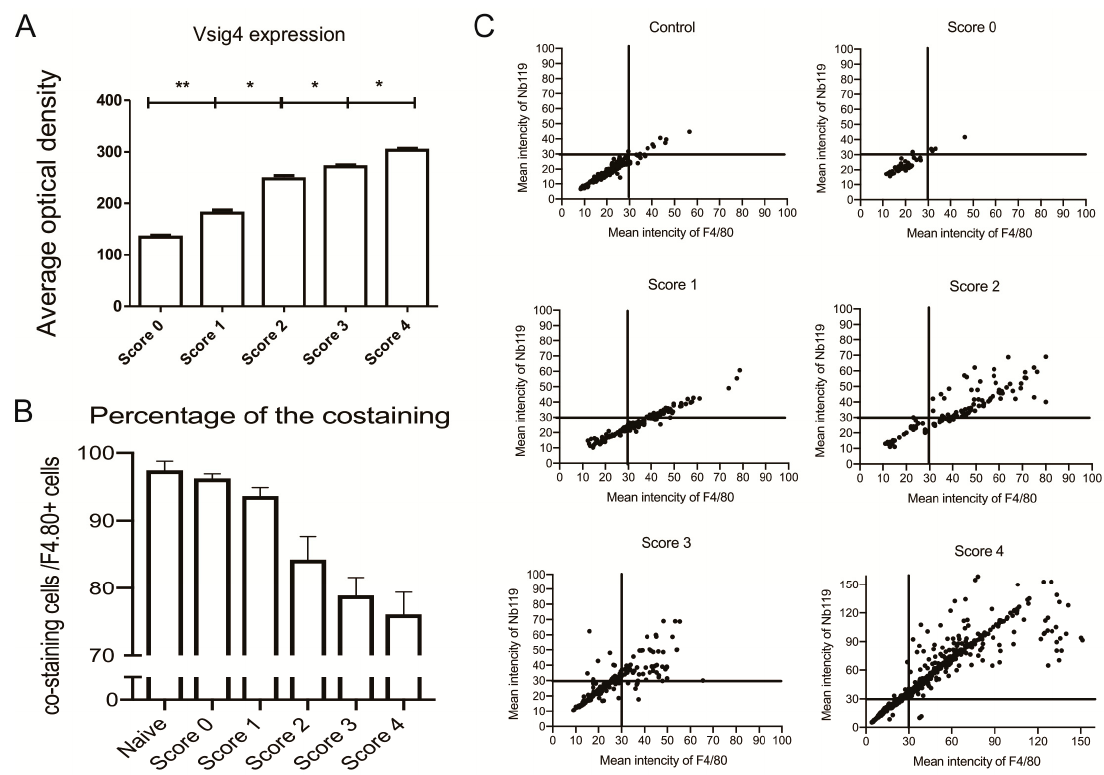
Figure 6. Immunofluorescence analysis in ankle sections of CIA mice having different clinical scores: ( A ) Vsig4 expression in total cells; ( B ) the percentage of Vsig4 and F4/80 contained within F4/80 positive cells. Data are presented as mean SEM. Levels of significance were calculated using one-way ANOVA. Values are means ± SEM (*= p < 0.05, ** = p < 0.01, n = 5). ( C ) The scatter plots of immunofluorescence analysis for Vsig4 mean intensity vs. F4/80 mean intensity in ankle sections of CIA mice having different clinical scores, scatter plots of left hind ankles from five representative mice are shown for each clinical score group.